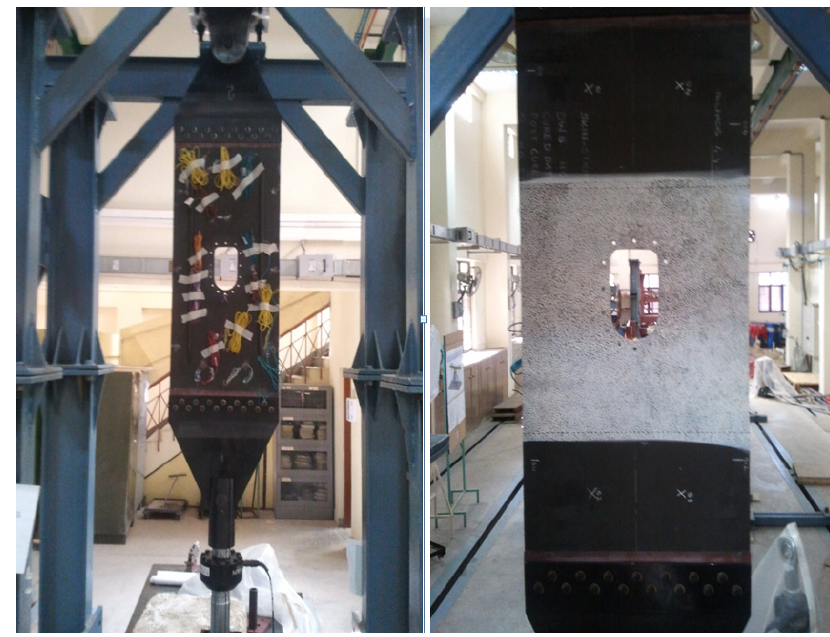
Figure 18. Panel subjected to quasi-static tensile loading (front and rear sides).